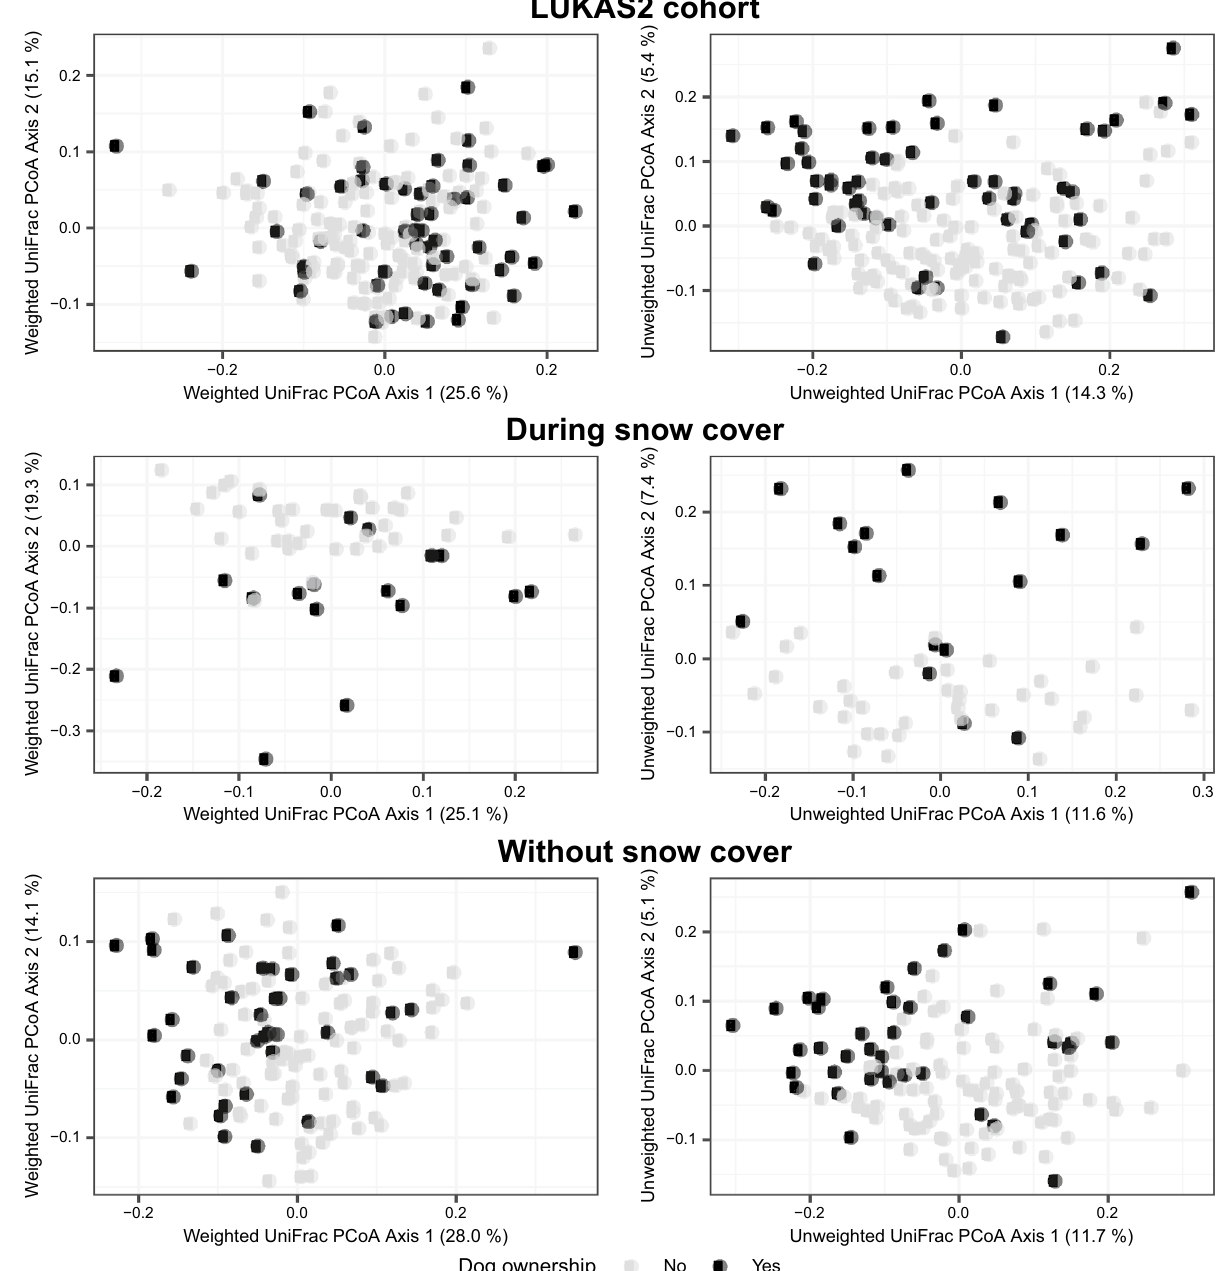
Figure 3. Plots of two bacterial axes scores by dog houses stratified by snow cover in LUKAS2. Plots of the first (PCoA1) and the second (PCoA2) axes scores from bacterial weighted and unweighted UniFrac based Principal Coordinate Analyses in LUKAS2 cohort by houses with (black dots) or without (grey dots) dog(s). Percentages of the variance explained by the axis scores are in the parentheses. Top two plots were made using dust samples from the whole LUKAS2 cohort (excl. farmers), two middle plots with samples collected without snow cover, and two plots in the bottom with samples when snow was on the Fungal taxa associated with the dog‑keeping. Only 5 fungal taxa, including two genera ( Arthrin- ium and Leucosporidiella ), were associated with dog ownership in LUKAS2 after correcting for multiple testing (Additional Table S4). Of these two, only the genus Leucosporidiella was more abundant in the dog than non- dog homes, and this result replicated in LISA (Table 1). In addition, the relative abundance of Udeniomyces was higher in the dog than non-dog homes in LUKAS2 when samples were collected while snow covered the ground (Additional Table S3).